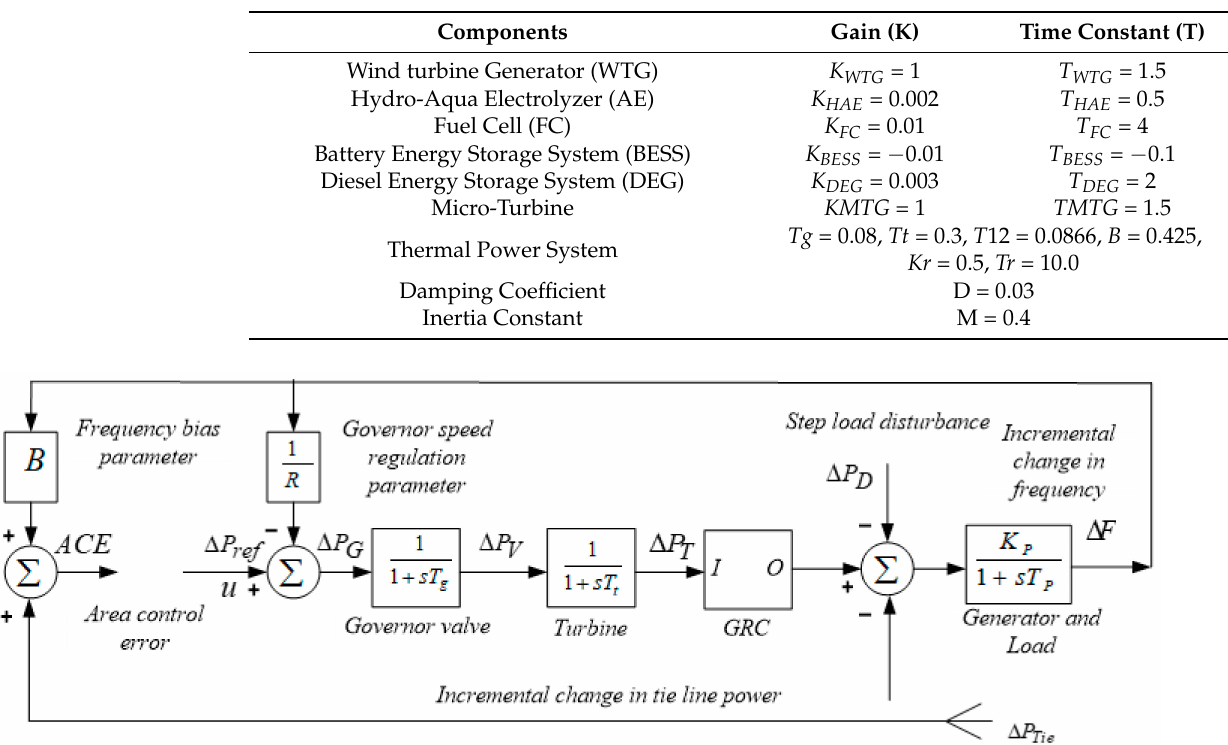
Table 1. Parameters used for the simulation of the power plant model under study.